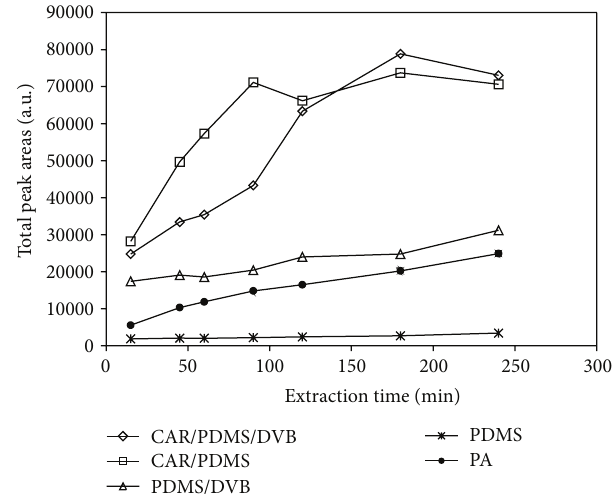
Figure 1: Total absorption peak areas (arbitrary unit) for CAR/ PDMS/DVB, CAR/PDMS, PDMS/DVB, PDMS, and PA fibres at different extraction time (15, 45, 60, 90, 120, 180, and 240